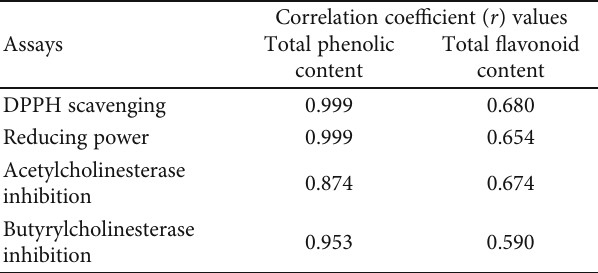
Table 3: Correlation of total phenolic and fl avonoid contents from E . fl uctuans with cholinesterase inhibition and antioxidant activities.